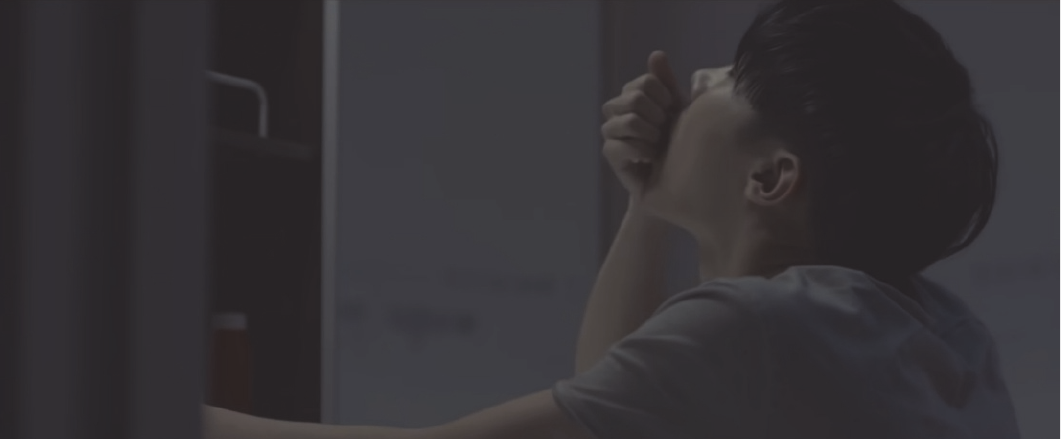
<Figure 3> Image of Overdose/Self-harm/Suicide in BTS. (2015a). “I NEED U” Official MV.